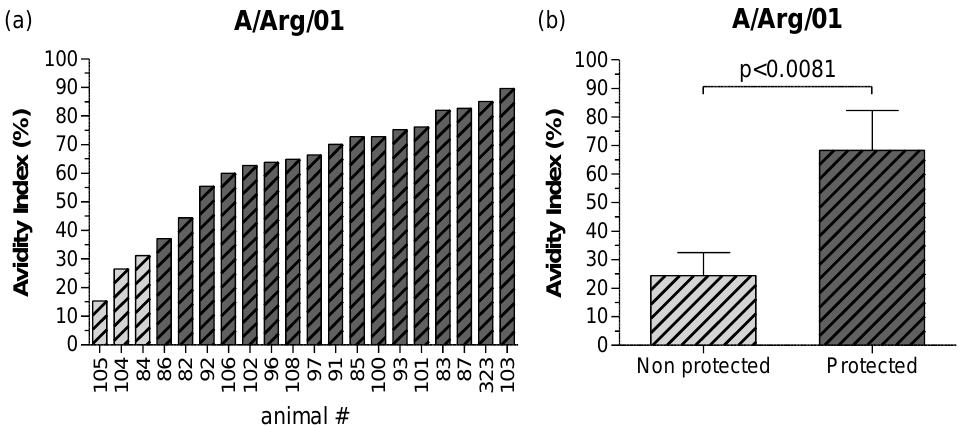
Figure 6. Avidity of the IgG antibodies against the FMDV A/Arg/01 at 30 dpv. The avidity of the FMDV-specific IgG antibody responses against the A/Arg/01 strain was measured by Avidity ELISA. ( a ) Avidity indexes (AI) for all vaccinated animals following an increasing order. Non-protected animals are indicated as clear shaded bars. ( b ) Mean AI in animals protected and non-protected against heterologous challenge at 30 dpv. Bars represent the mean value ± SD. Statistical differences were determined by Mann – Whitney test.